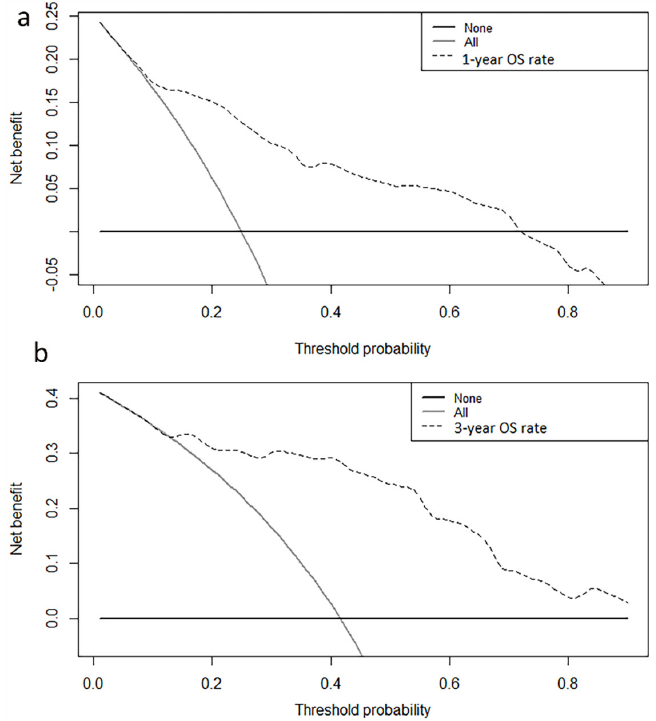
Figure 6. The decision curve analysis of the ( a ) 1-year overall survival rates, ( b ) 3-year overall survival rates for the training and validation cohorts.